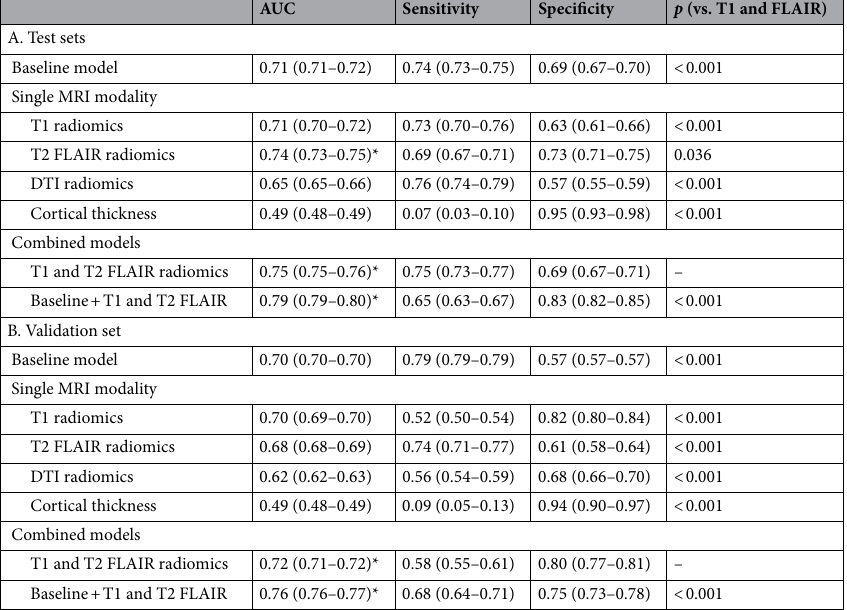
Table 2. Performances of the prediction models. 95% confidence intervals are presented in brackets. AUC area under the curve, ApoE apolipoprotein E genotype, MRI magnetic resonance imaging, FLAIR fluid attenuation inversion recovery, DTI diffusion tensor imaging. *Significantly higher than baseline model ( p <